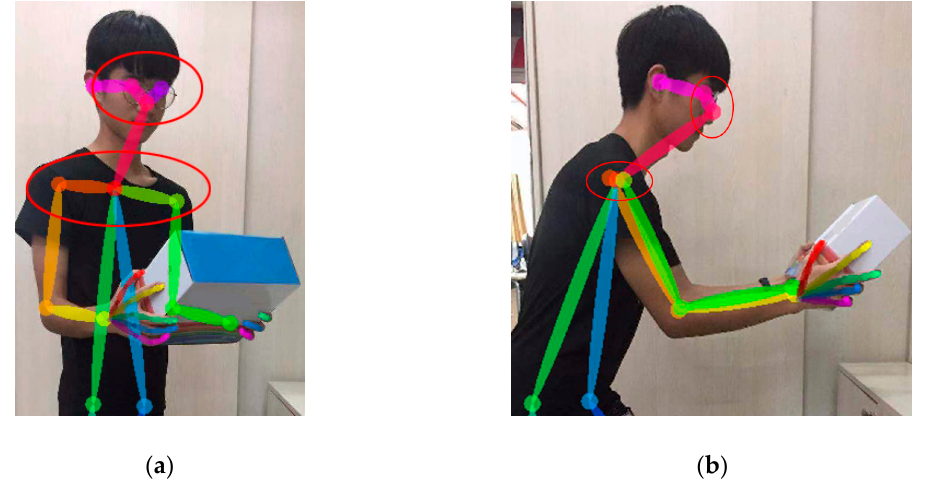
Figure 4. Compared with the exposed area of the chest and the face in the reverse state, ( a ) shows the waist and the head twisted state; ( b ) shows the normal non-twisted state.